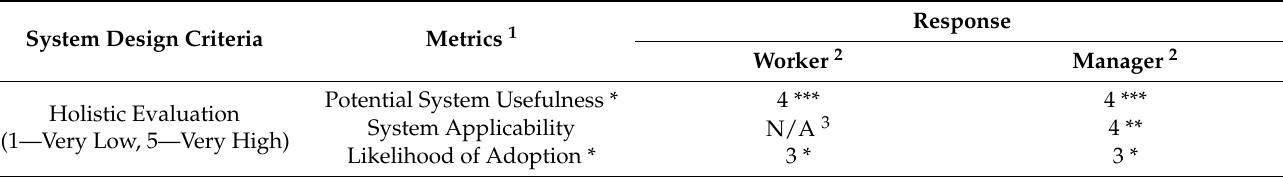
Table 7. Holistic